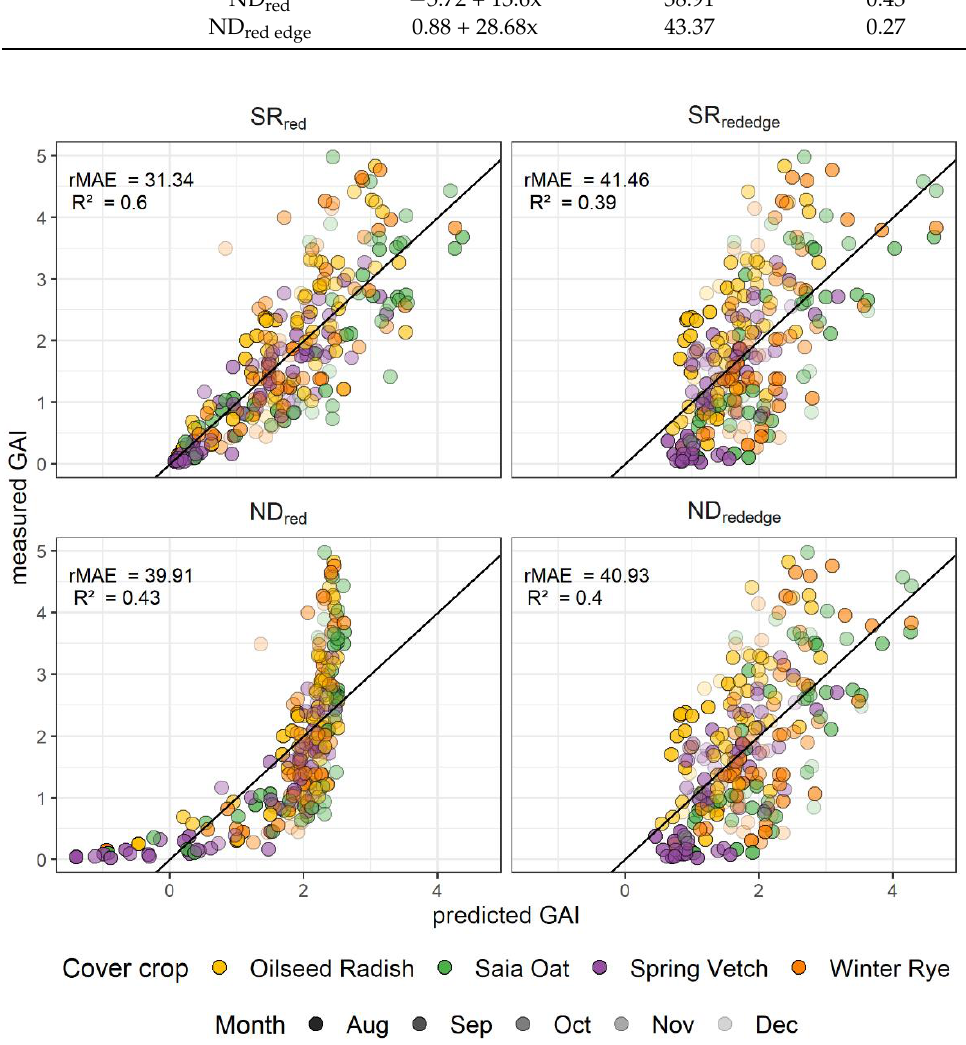
Figure 5. Universal models differing in vegetation indices (simple ratio (SR red , SRred edge ,) and normalised difference vegetation indices (ND red , ND red edge ) for the estimation of the green area index (GAI). Model performance was assessed with relative mean absolute error (rMAE) (%) and R 2 .